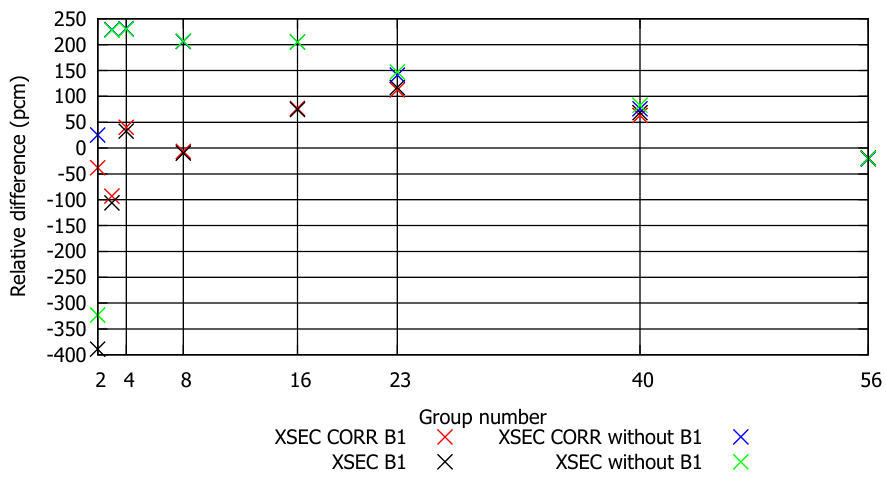
Figure 8. k eff relative deviation with XSEC input